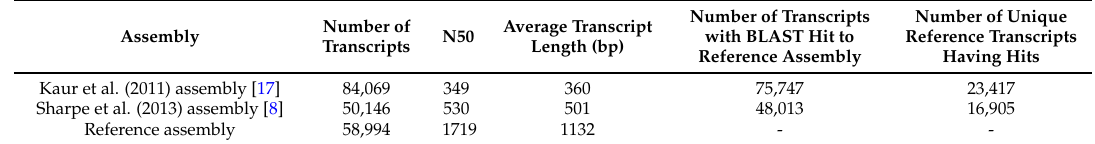
Table 2. Overview of different assembly statistics and BLAST analysis.